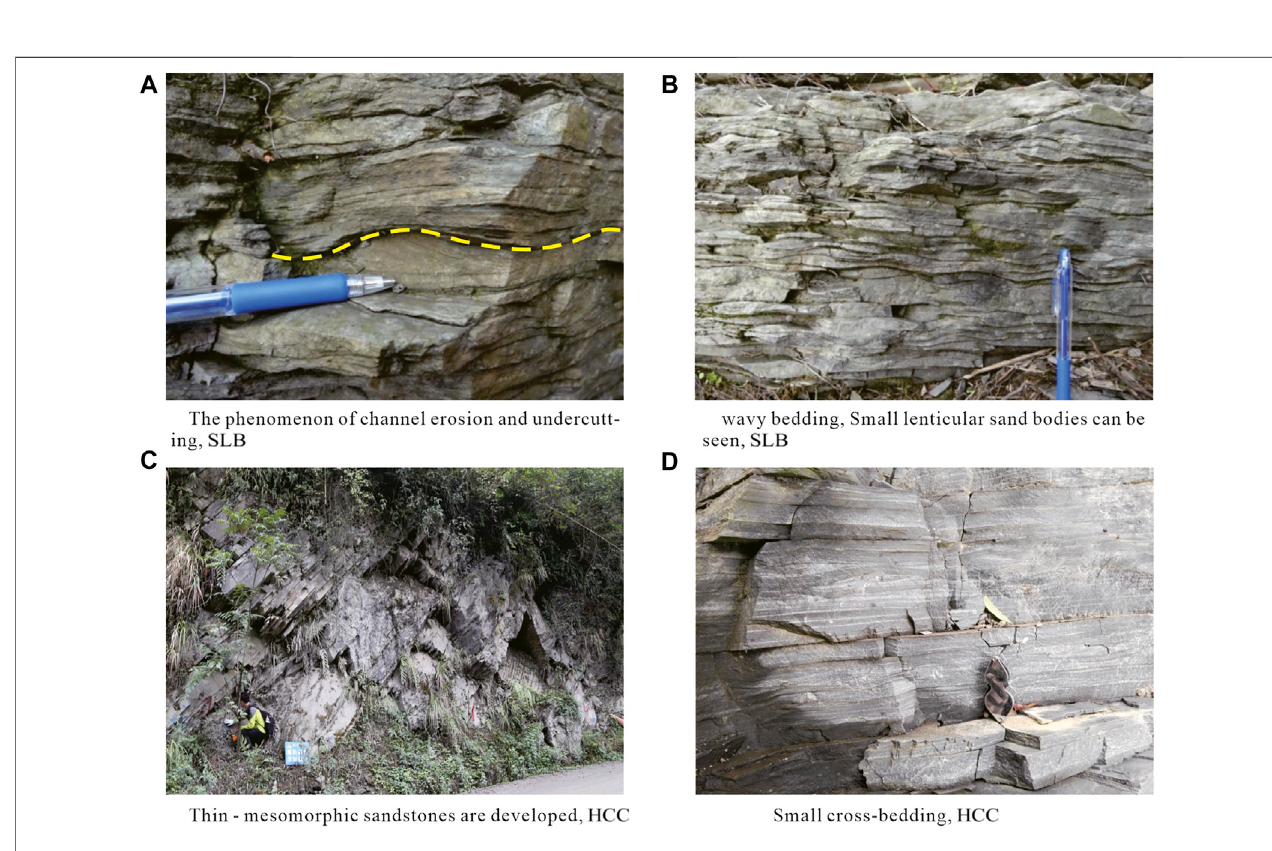
FIGURE 2 | Field sedimentary structure of Xiaoheba Formation (A) The phenomenonof channel erosion and undercutting, SLB, (B) wavy bedding, small lenticular sand bodies can be seen, SLB, (C) Thin — mesomorphic sandstones are developed, HCC; (D) Small cross-bedding HCC.